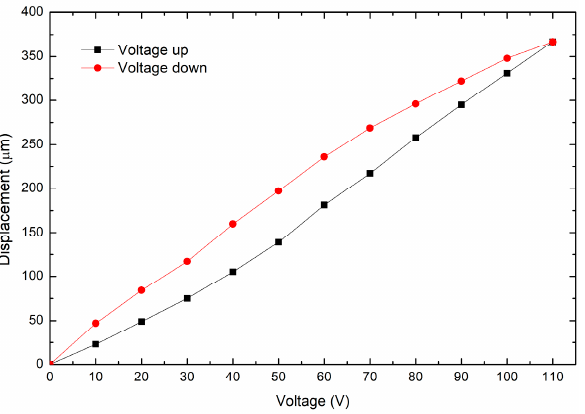
Figure 9. Displacement generated by the piezoelectric stack, without mechanical load.